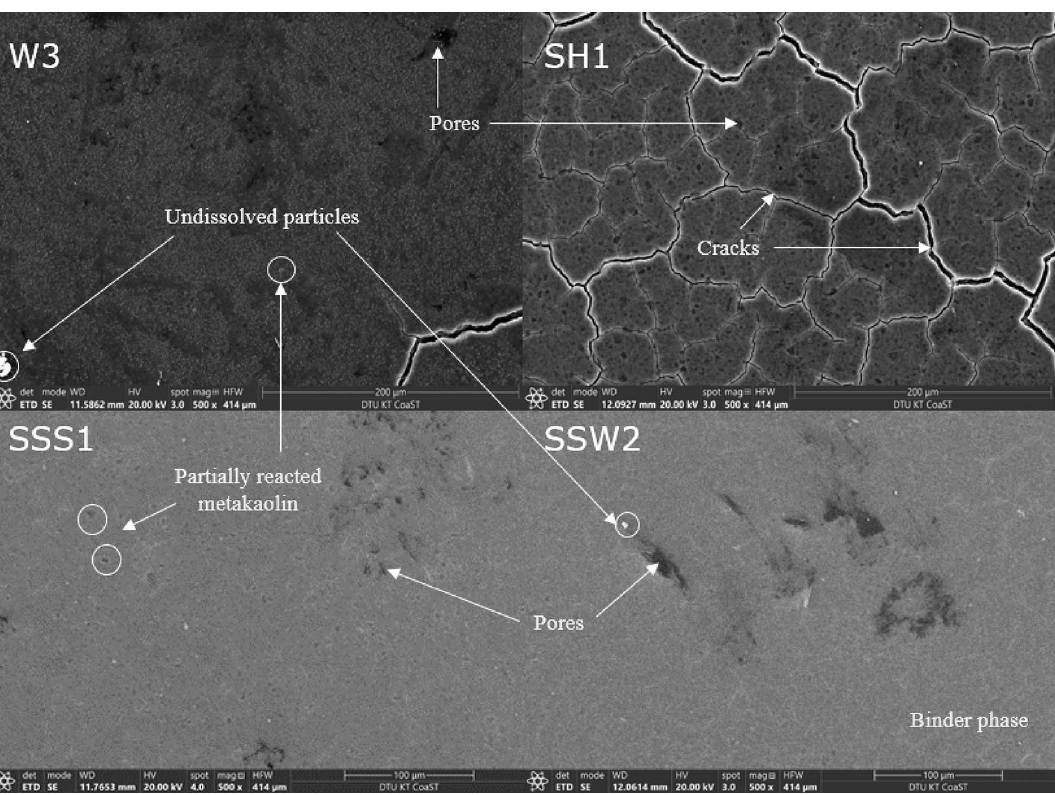
Fig. 9 SEM images of 28 day cured samples (W3, SH1, SSS1, SSW2) with varying content of water and sodium hydroxide measured at 20 kV and ×